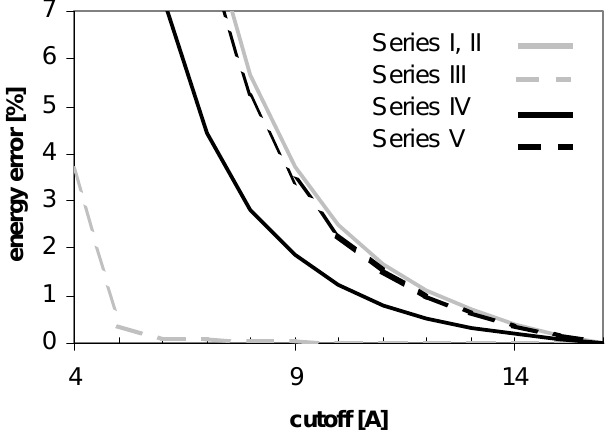
Figure 15. Dependency of energy error on cutoff (for peptide P2) as calculated by AMBER 5.0 and 6.0 with different setup. Denotation: Series I: AMBER 6.0 - cutoff method (USE_PME=0, EEDMETH=4); Series II: Amber 6.0 - PME, E without correction (USE_PME=1, EEDMETH=1, vdw VDWMETH=0); Series III: Amber 6.0 - PME, Evdw with correction (USE_PME=1, EEDMETH=1, VDWMETH=1); Series IV: Amber 5.0 - cutoff method; Series V: Amber 5.0 - PME